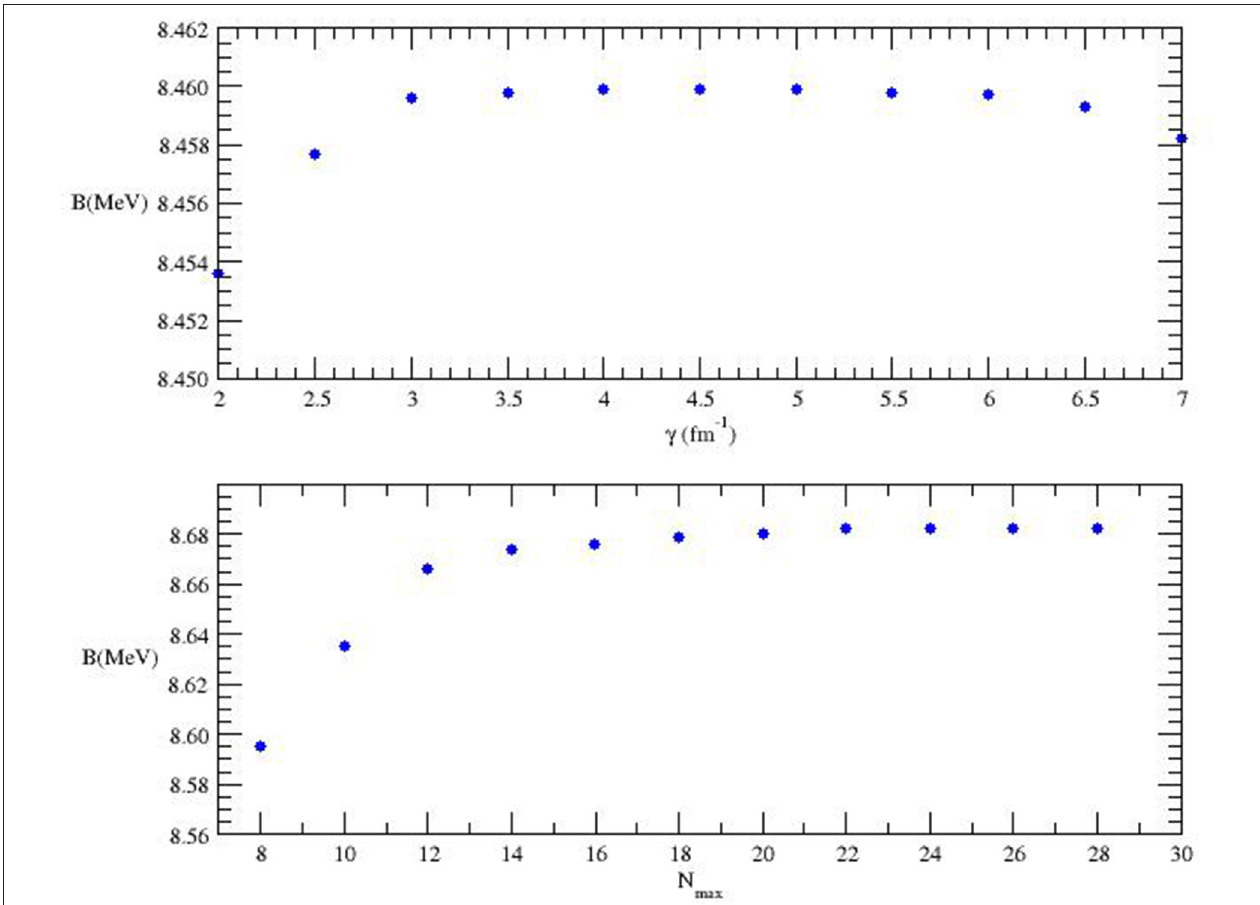
FIGURE 1 | (Top) The binding energy B (in MeV) as function of the parameter14 γ (in fm − 1 ) for the Volkov potential model [12], with G max N max m p . (Bottom) The binding energy B (in MeV) as function of the parameter N max for the AV4 ′ potential model [16], with G max 16, and using m n = = j max m p 8 and γ 4 fm − 1 , and using m n = = =